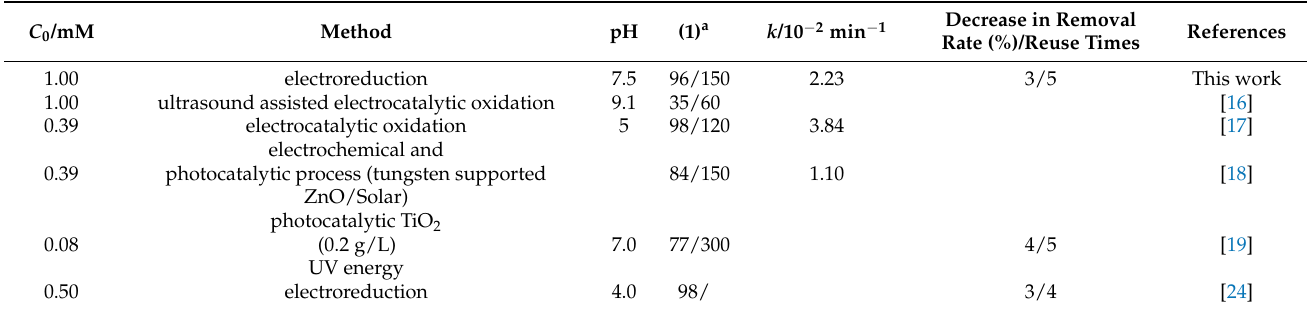
Table 1. Comparison of electro-reduction with other processes for degradation of 3-CP. (1) a 3-CP removal/reaction time (%/min).